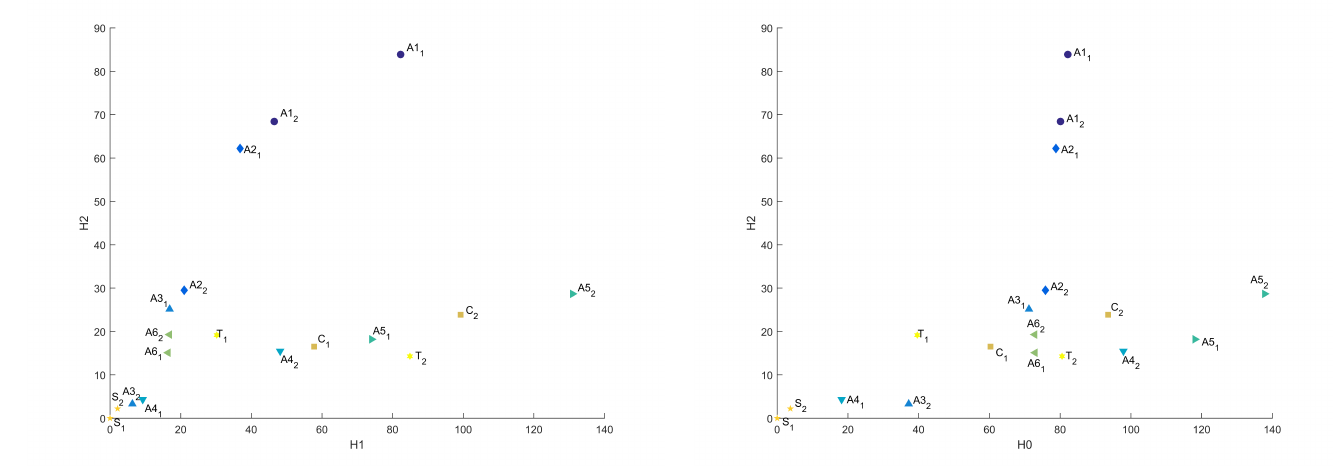
Figure 7. Common distances in Heat Kernel metric in H 1 – H 2 and H 0 – H 2 coordinates.